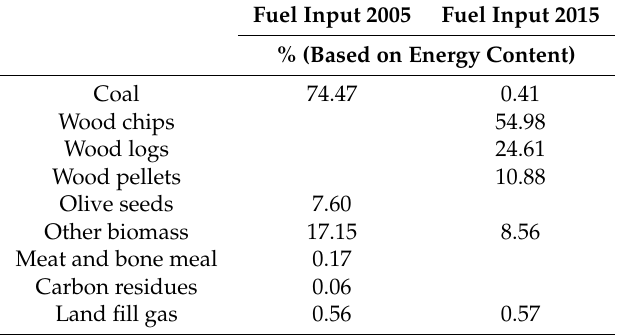
Table 1. Fuel inputs for the biomass year (2005) and the coal year (2015) based on energy